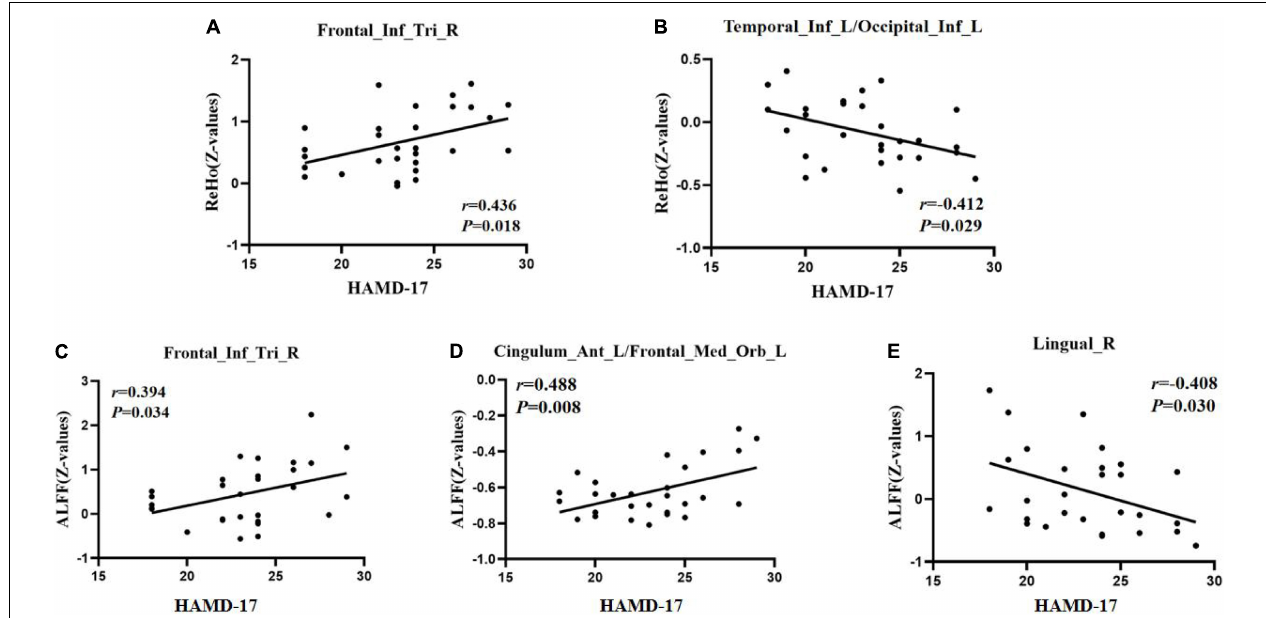
FIGURE 6 | Positive correlation between the ReHo/ALFF values of abnormal brain regions and the HAMD-17 scores. (A) ReHo values in the recurrent depressive episode (RDE) group. (C) ALFF values in the RDE group. (D) ALFF values in the first depressive episode (FDE) group. Negative correlation between the ReHo/ALFF values of abnormal brain regions and the HAMD-17 scores. (B) ReHo values in the FDE group. (E) ALFF values in the FDE group. Frontal_Inf_Tri_R, right inferior frontal triangular gyrus; Cingulum_Ant_L/Frontal_Med_Orb_L, left anterior cingulate cortex/orbital part of the left middle frontal gyrus; Temporal_Inf_L/Occipital_Inf_L, left inferior temporal gyrus/left inferior occipital gyrus; Lingual_R, right lingual gyrus; ReHo, regional homogeneity; ALFF, amplitude of low-frequency fluctuations; HAMD-17, 17-item Hamilton Rating Scale for